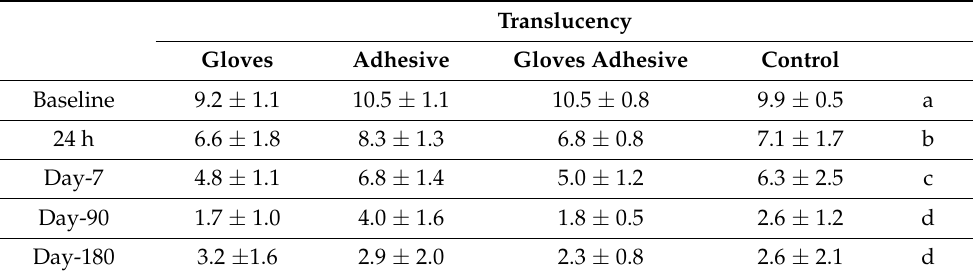
Table 3. Data resulting from translucency test for composite resin specimens handled/modeled under different techniques (gloved-hands and/or adhesive), in different evaluation times *.